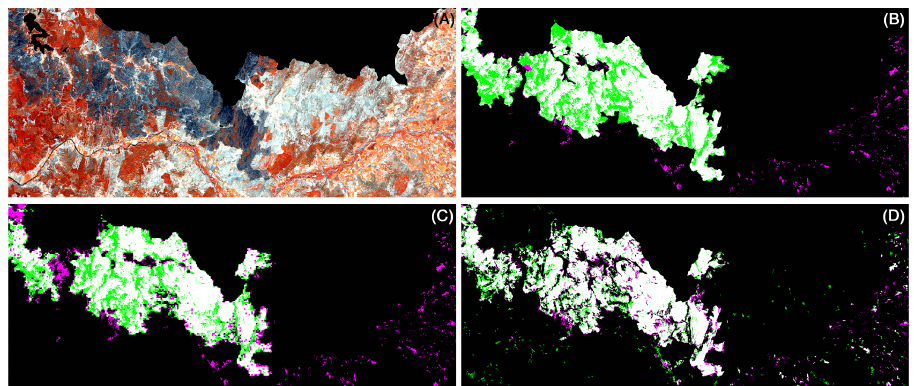
Figure 6. Burned area classifications for the validation area ( A ), CONAF’s Method ( B ), FIRECCI Algorithm ( C ) and ELM ( D ). White shows spatial agreement, and magenta indicates omission and green shows